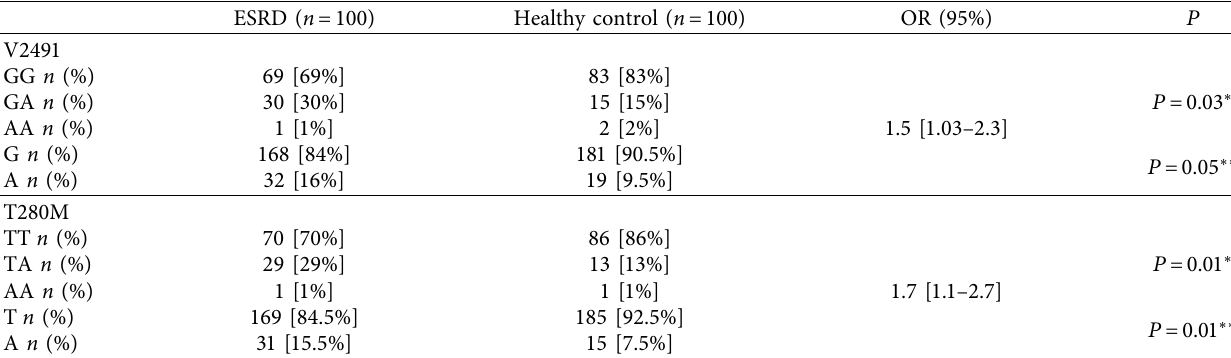
Data were expressed as mean ± SD. SD: standard deviation. Table 2: Comparison of fractalkine V2491 and T280M genotypes between patients and control.